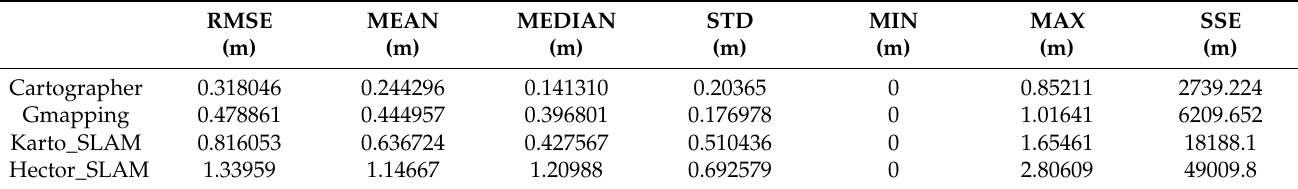
( b ) ( c ) Figure 9. Comparison of absolute positional errors between multiple SLAM systems: ( a ) the graph of absolute pose errors of four SLAM methods, ( b ) statistic errors of four SLAM methods, and ( c ) box plots of four SLAM methods.